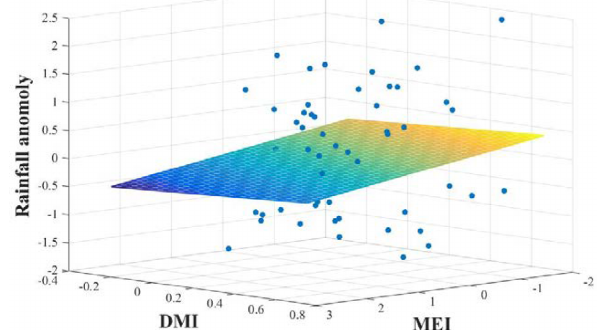
Figure 3. Linear regression of rainfall anomaly on MEI and DMI. High values of MEI and DMI are associated with low values of rainfall.